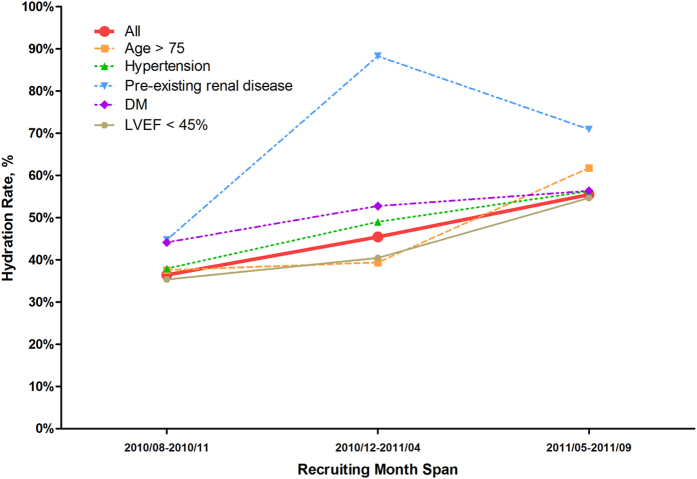
The trend of hydration rate over time in patients with different risk factors in three groups.Abbreviations: DM, diabetes mellitus; LVEF, left ventricular ejection fraction.